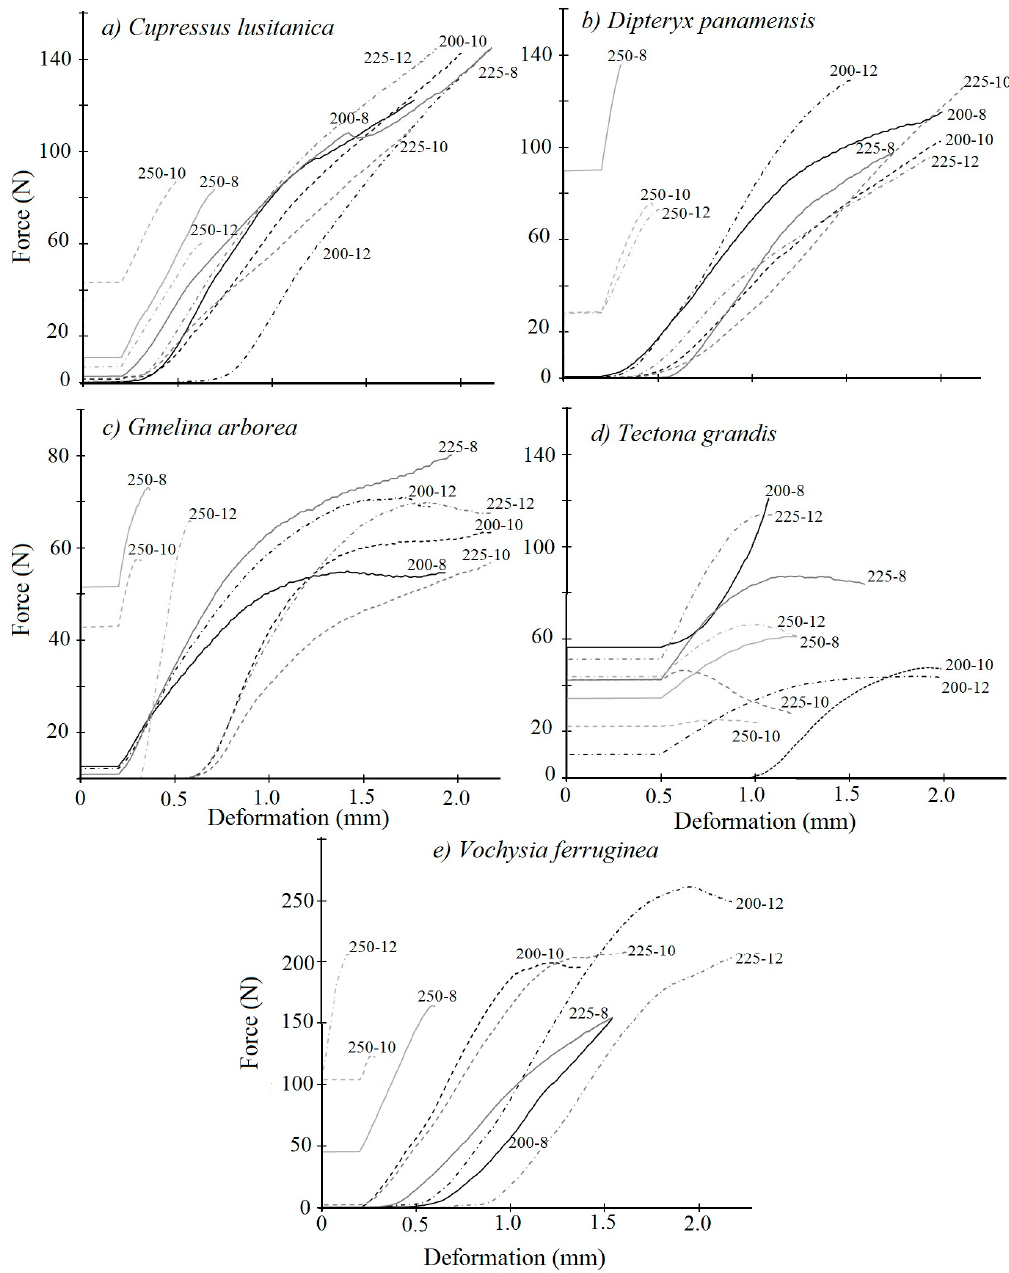
Figure 4. Compression force variation in relation to the deformation of pellets torrefied at different temperatures and times for five types of biomass from woody tropical species: ( a ) compression force in Cupressus lusitanica ; ( b ) compression force in Dipteryx panamensis ; ( c ) compression force in Gmelina arborea ; ( d ) compression force in Tectona grandis ; ( e ) compression force in Vochysia ferruginea .